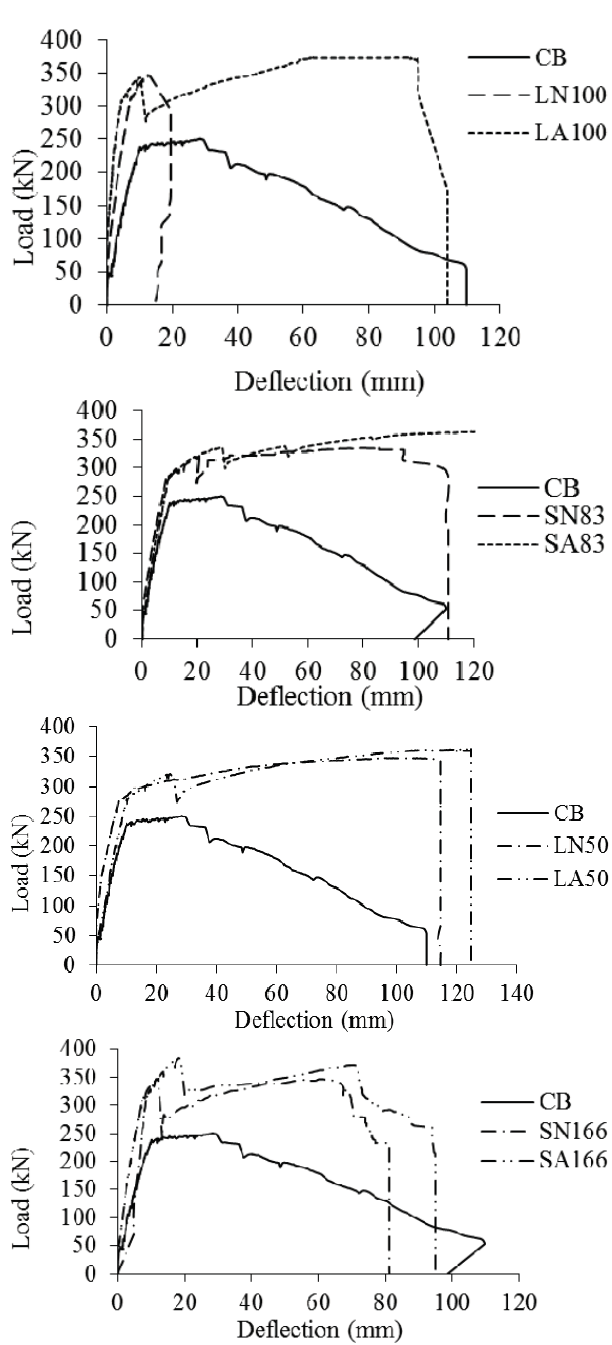
Figure 6. Comparison of load deflection behavior of test